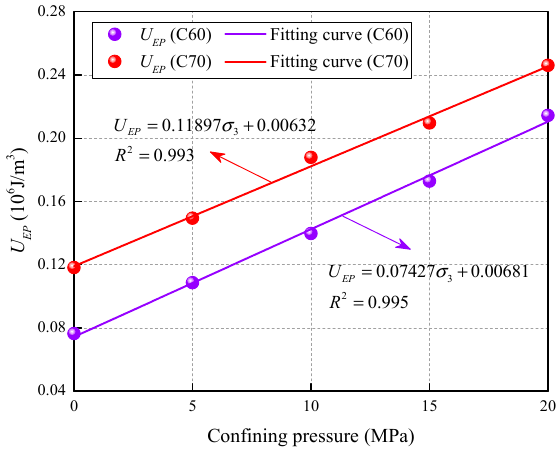
U . Figure 6. Relationship between confining pressure and U EP . EP